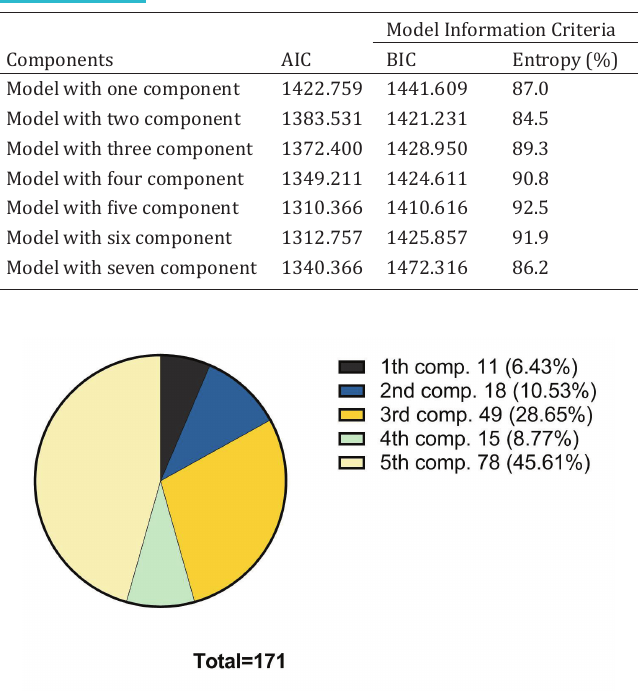
Figure 5. Obtained class sizes and mixing probabilities for components with closest class membership probabilities